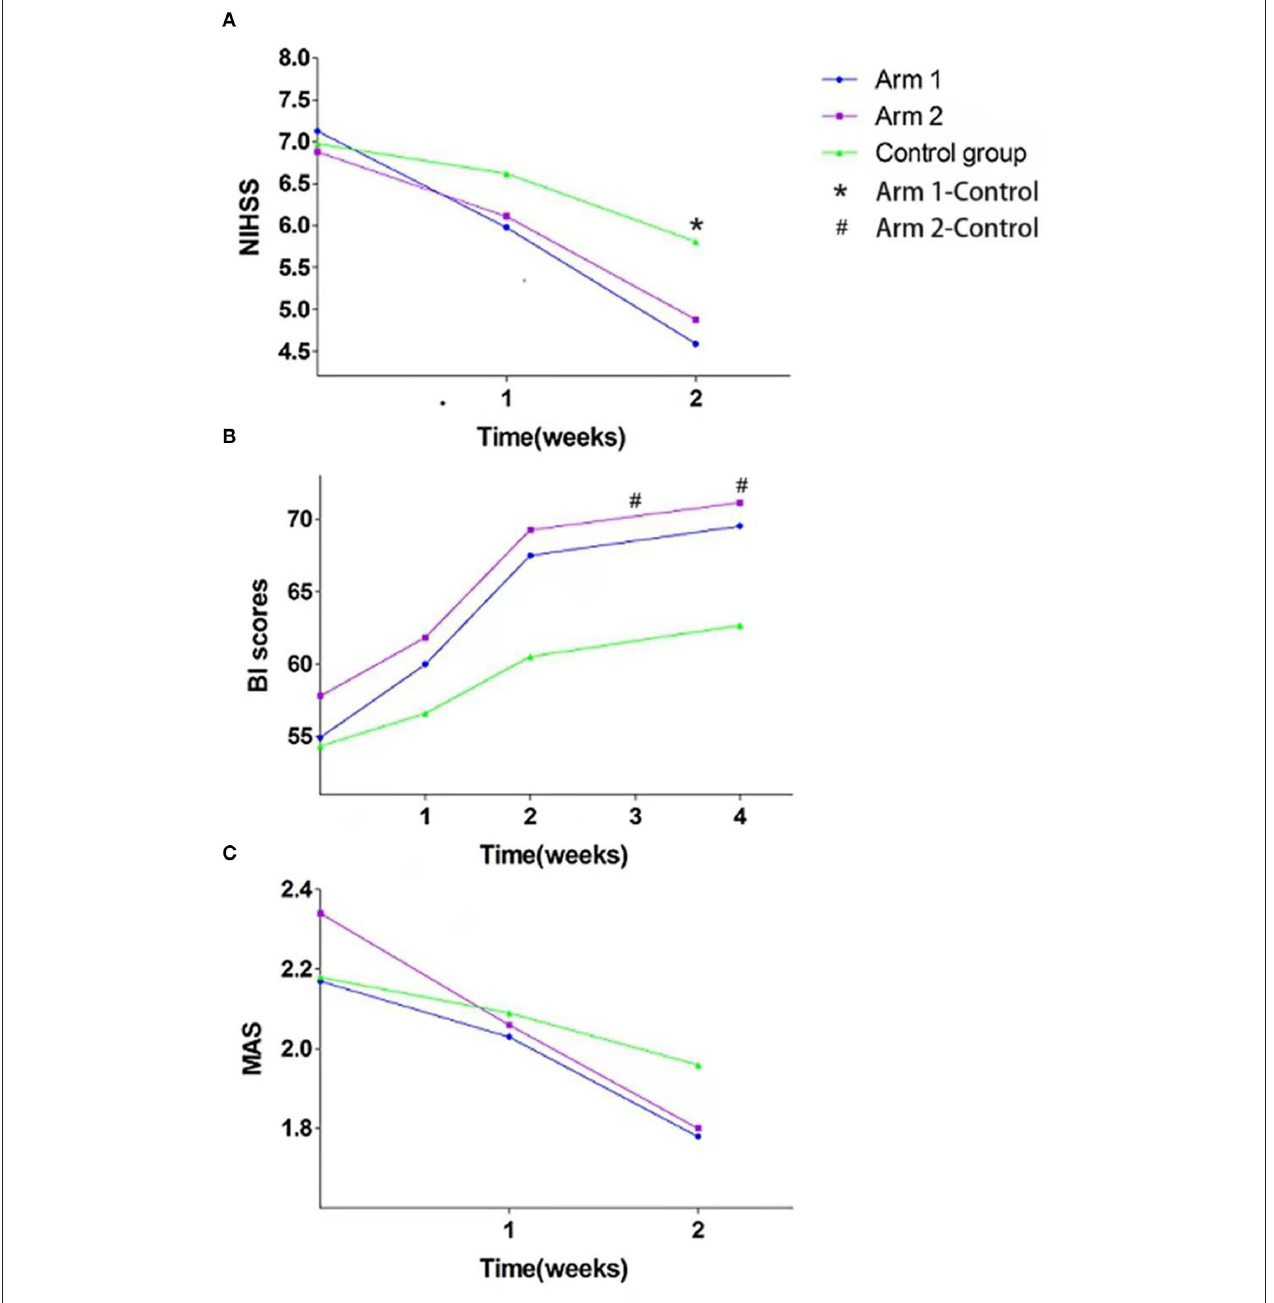
FIGURE 2 | Scores of the (A) National Institutes of Health Stroke Scale (NIHSS), (B) the Barthel Index (BI), and (C) the Modified Ashworth Scale (MAS) in the three groups. *, # denotes significant